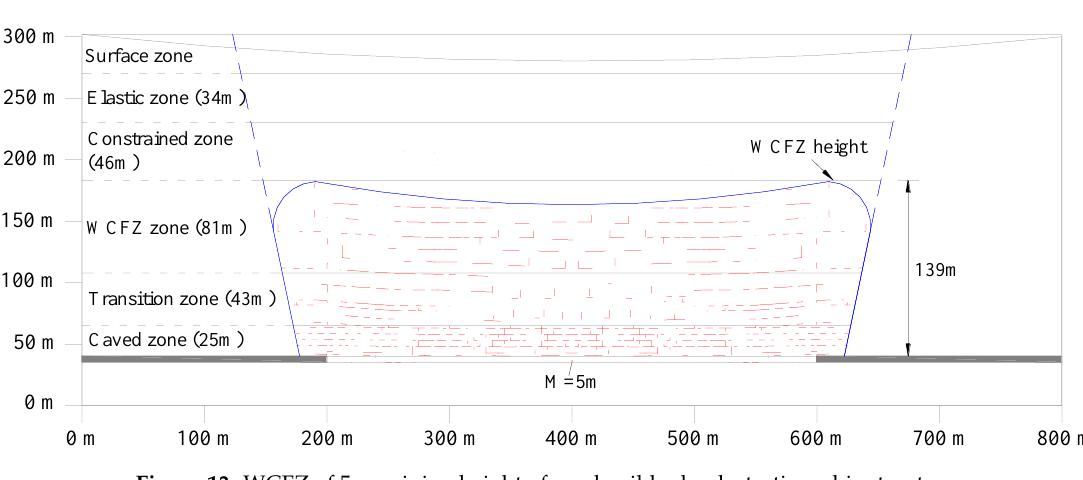
Figure 13. WCFZ of 5 m mining height of sand-soil-bedrock stratigraphic structure. Table 5. Numerical simulation results of WCFZ height and the ratio of WCFZ height to mining height. The WCFZ of 5 m mining height is shown in Figure 13. The optimized model parameters were used, the heights of WCFZ zone under different mining heights were calculated for 4 different Mining stratigraphic structures, and the results are shown in Table 5.